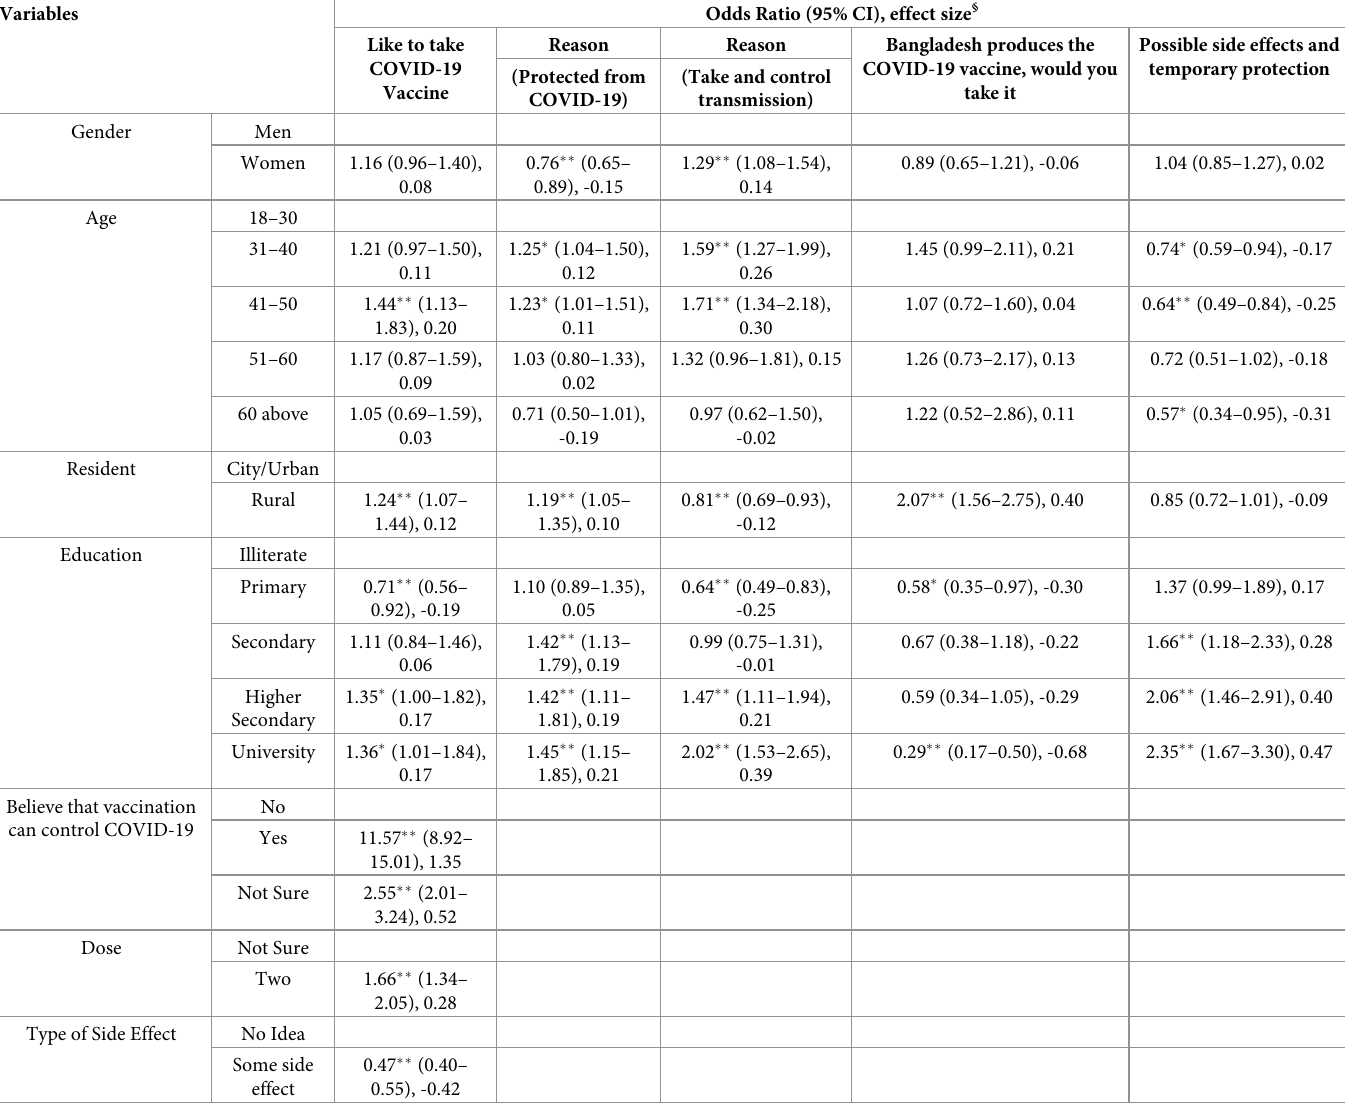
Table 5. Logistic regression on respondents’ opinion of acceptance of COVID-19 vaccine.